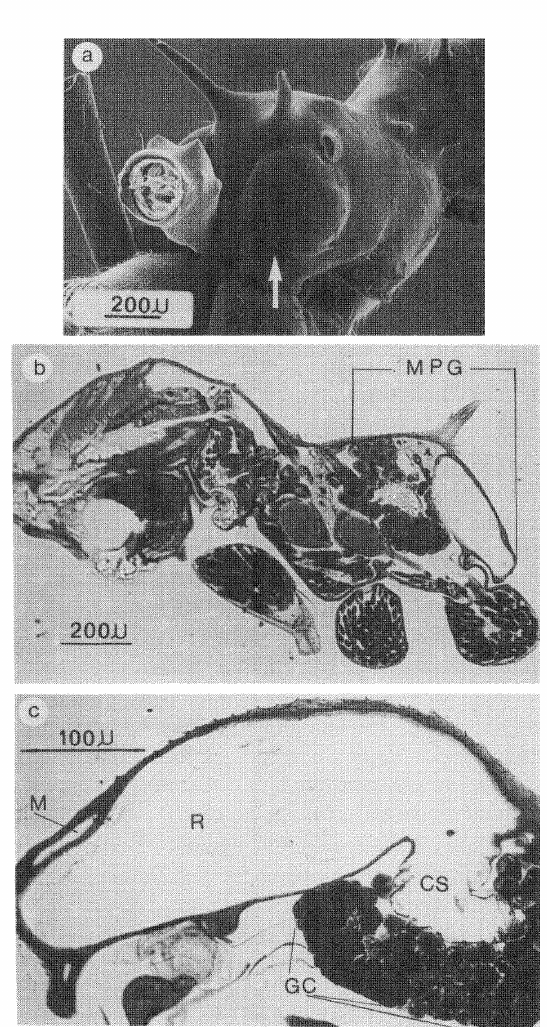
Fig. I. The metapleural gland of Atta, illustrating the major anatomical feature of this organ, a. SEM micrograph of the mesosoma of A. cephalotes, showing the large pronounced vault (bulla) which covers the storage chamber. Arrow points to the slit-shaped opening (meatus). b. Longitudinal section through the mesosoma of A. sexdens, showing the large region of the metapleural gland (MPG). c. Longi- tudinal section through metapleural gland: CS collecting sac; GC glandular cells; M meatus; R storage chamber or